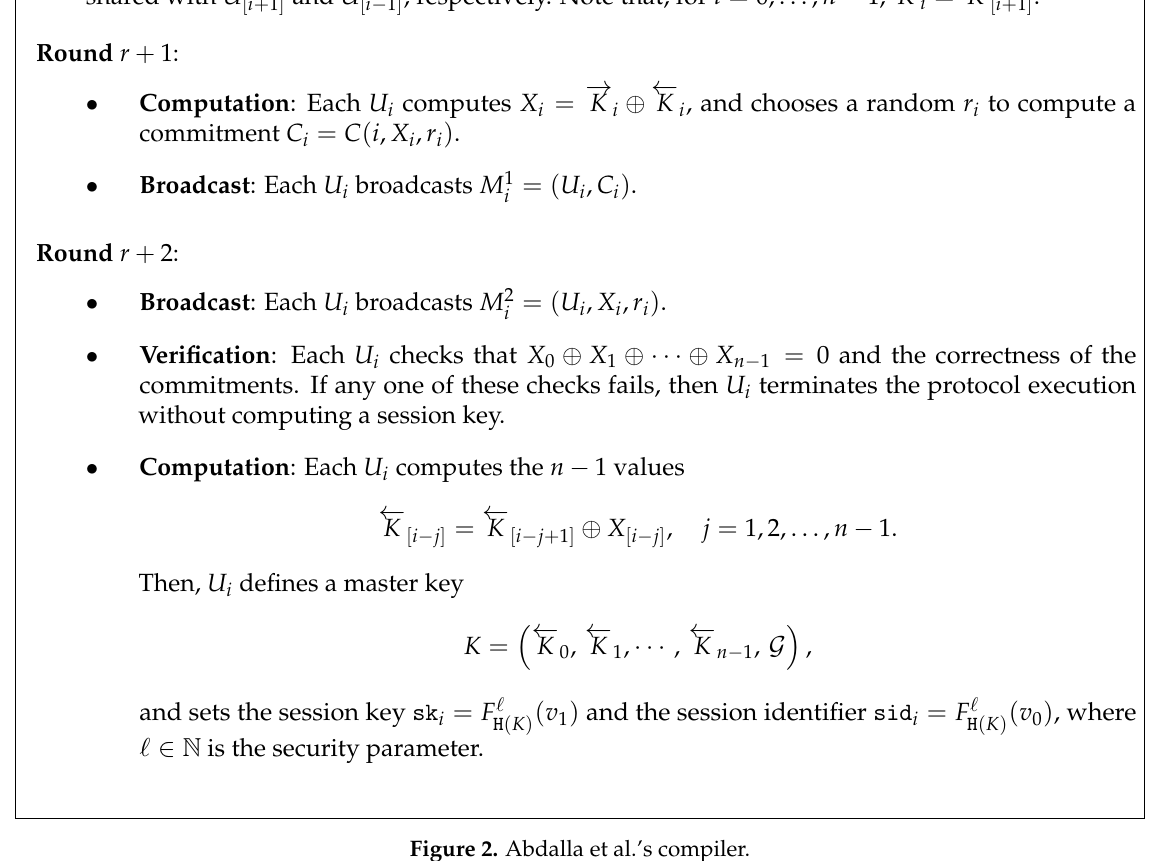
Figure 2. Abdalla et al.’s